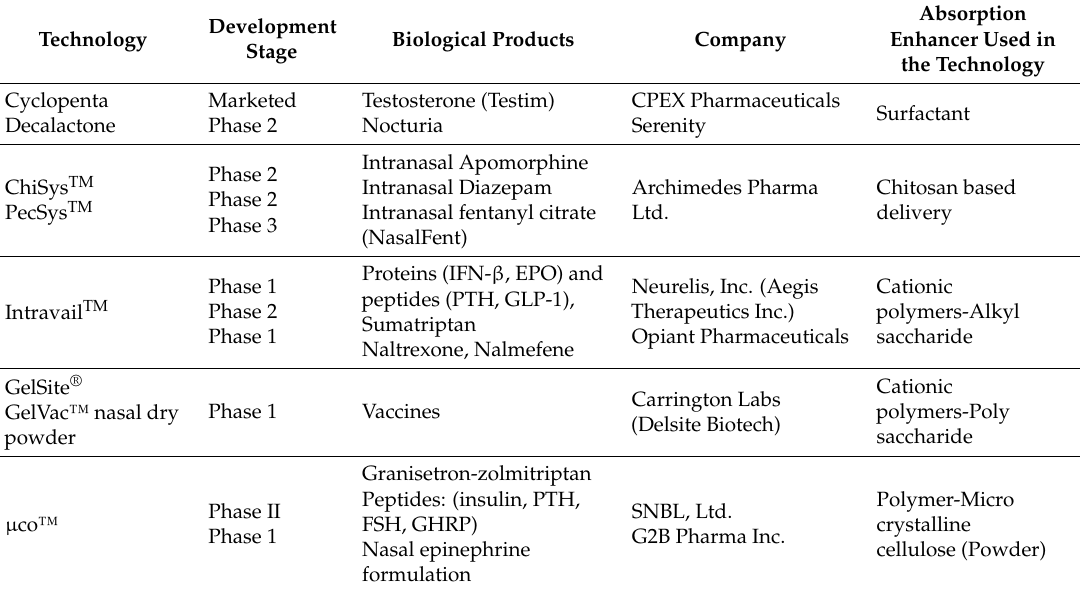
Table 2. Nasal and Inhalation products in development that employ penetration